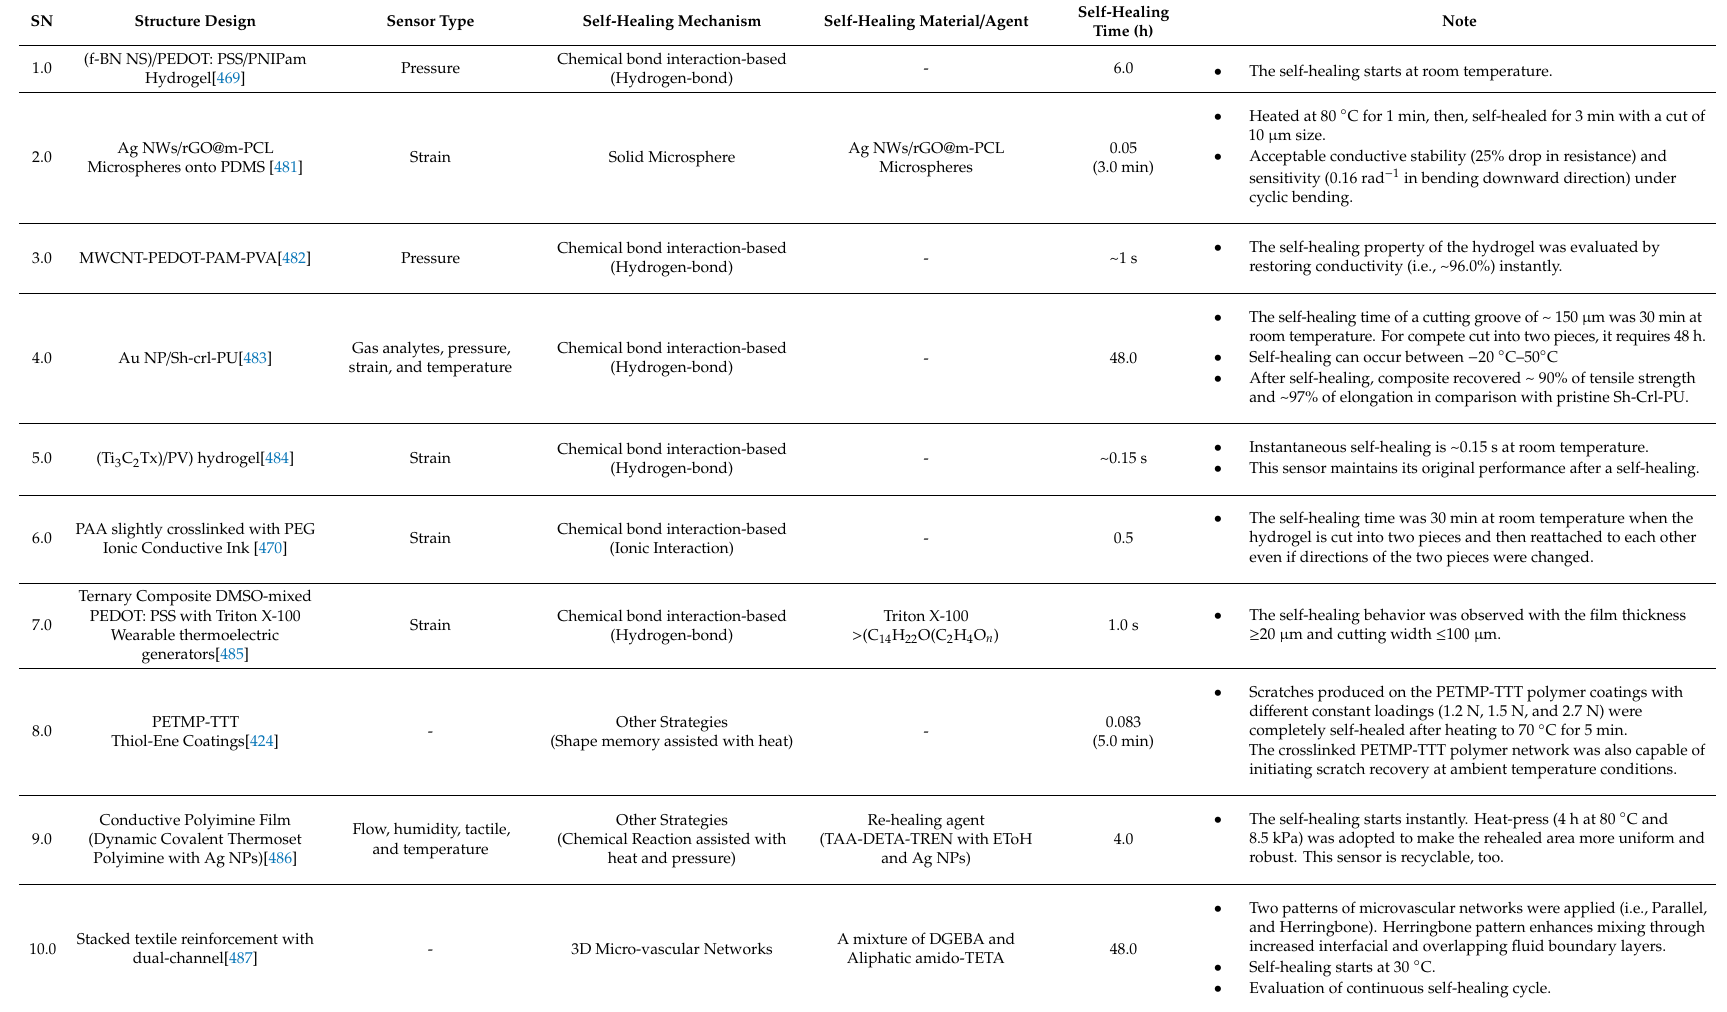
Table 5. List of self-healing mechanisms, along with some of their structure design